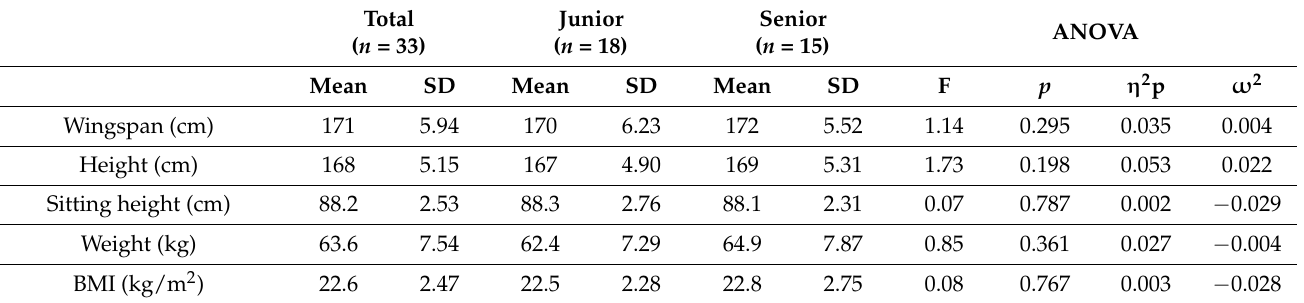
Table 2. Descriptive data and differences in basic measures according to